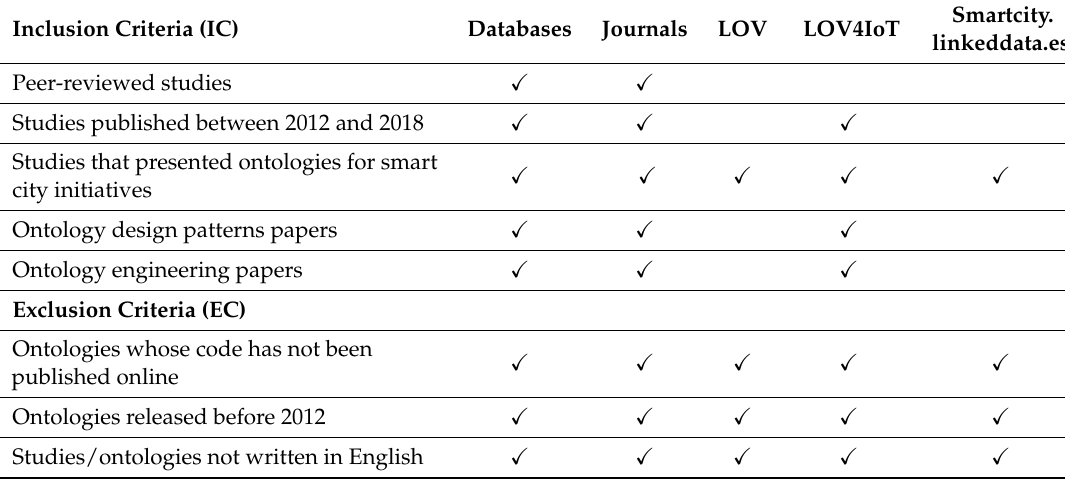
Table 2. Inclusion and exclusion